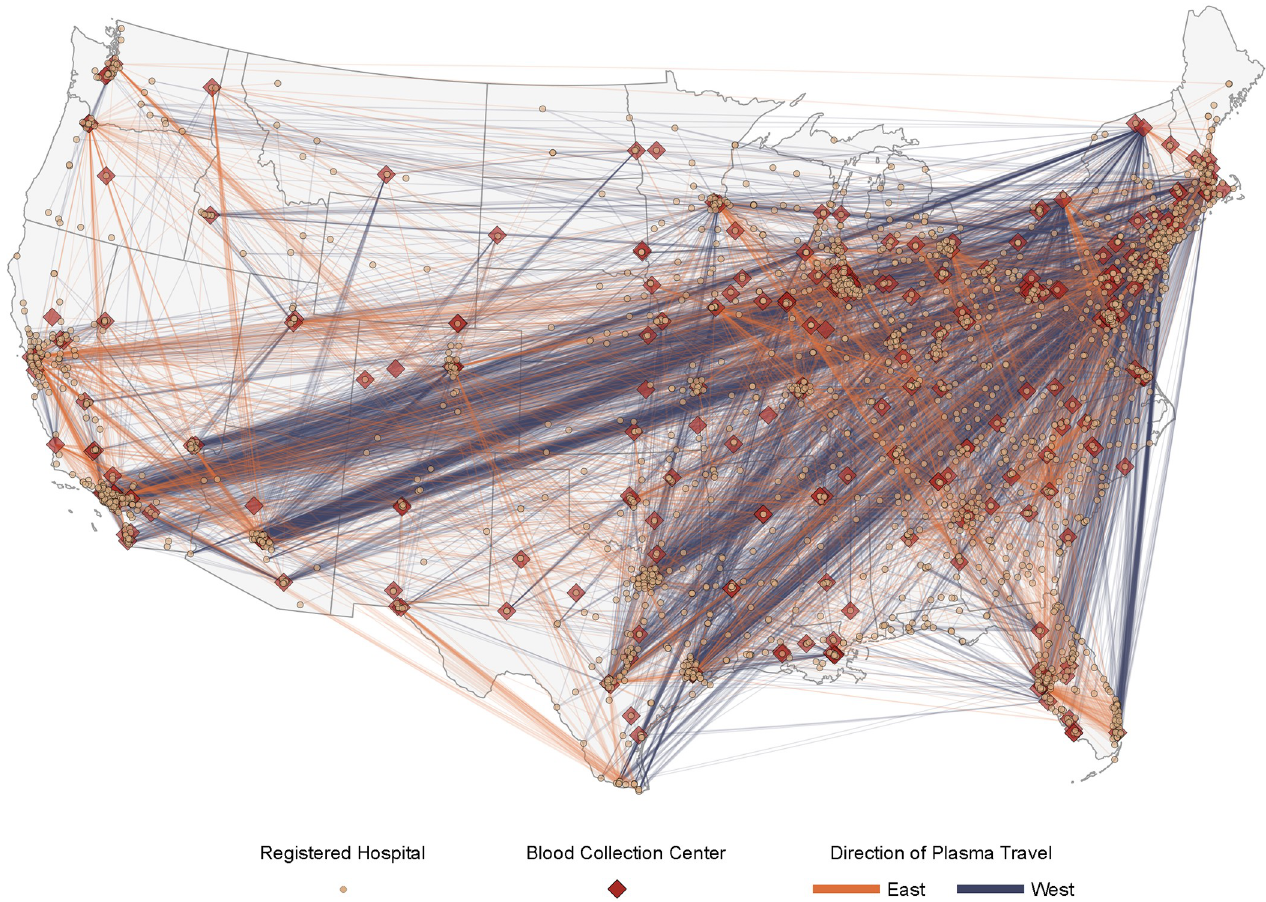
Fig 7. Travel paths of units of convalescent plasma from blood collection centers to sites of plasma transfusion within the contiguous US in the Expanded Access Program (EAP) for convalescent plasma. Map displaying the distance and direction of travel of convalescent plasma units in support of the EAP, with the thickness of each colored line directly proportional to the number of convalescent plasma units represented. Lines colored in blue represent a travel direction of east to west (e.g., New York City, NY, to Los Angeles, CA), and lines colored in orange represent a travel direction of west to east (e.g., Minneapolis, MN, to Tampa, FL). The US FDA–licensed or–registered blood collection facilities supplying plasma are presented as filled red diamonds, and acute care facilities are presented as filled yellow circles. The map does not display data from noncontiguous US locations, including facilities in Puerto Rico, Hawaii, and Alaska. The base layer of the geographical map was created using geographical data retrieved from the US Census Bureau (https://www2.census. gov/geo/tiger/TIGER2019/STATE/). No copyrighted material was used.